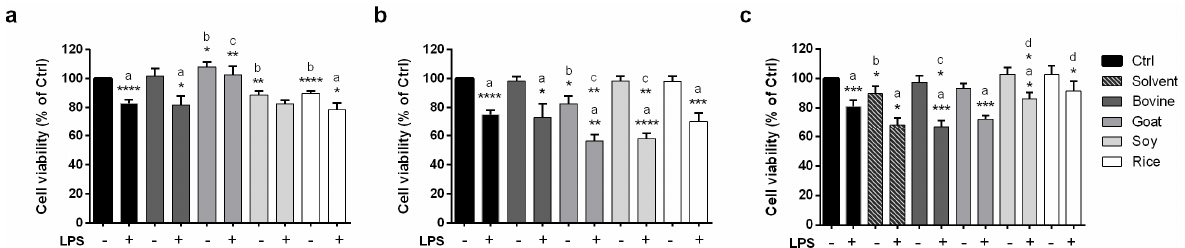
Figure 4. Effect of raw milks and their total and free lipid fractions on Caco-2 cell viability as assessed by an MTT assay. The bars represent the calculated mean value of cell viability percentages vs. Ctrl ± SEM ( n = 3) relatively to Caco-2 cells treated with raw milks ( a ) and their total lipid and free lipid fractions (25 µg/mL, ( b , c ), respectively) at basal conditions and 48 h after LPS stimulation. Ctrl: raw milks: only cells; total lipid and free lipid fractions from crude milks: DMSO. a: LPS-stimulated vs. unstimulated samples; b: crude milks/milk extracts treated samples vs. unstimulated control sample; c: crude milks/milk extracts treated samples + LPS vs. control sample + LPS; d: crude milks/milk extracts treated samples + LPS vs. solvent + LPS. * p < 0.05, ** p < 0.01, *** p < 0.001,**** p <